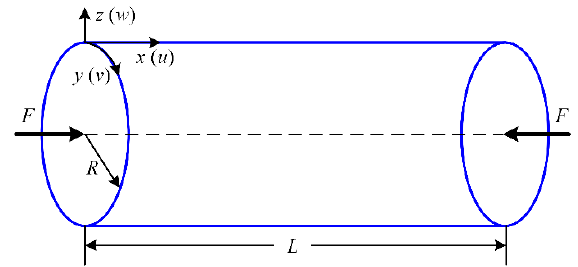
Figure 1. Schematic diagram of NFRC cylindrical shell.